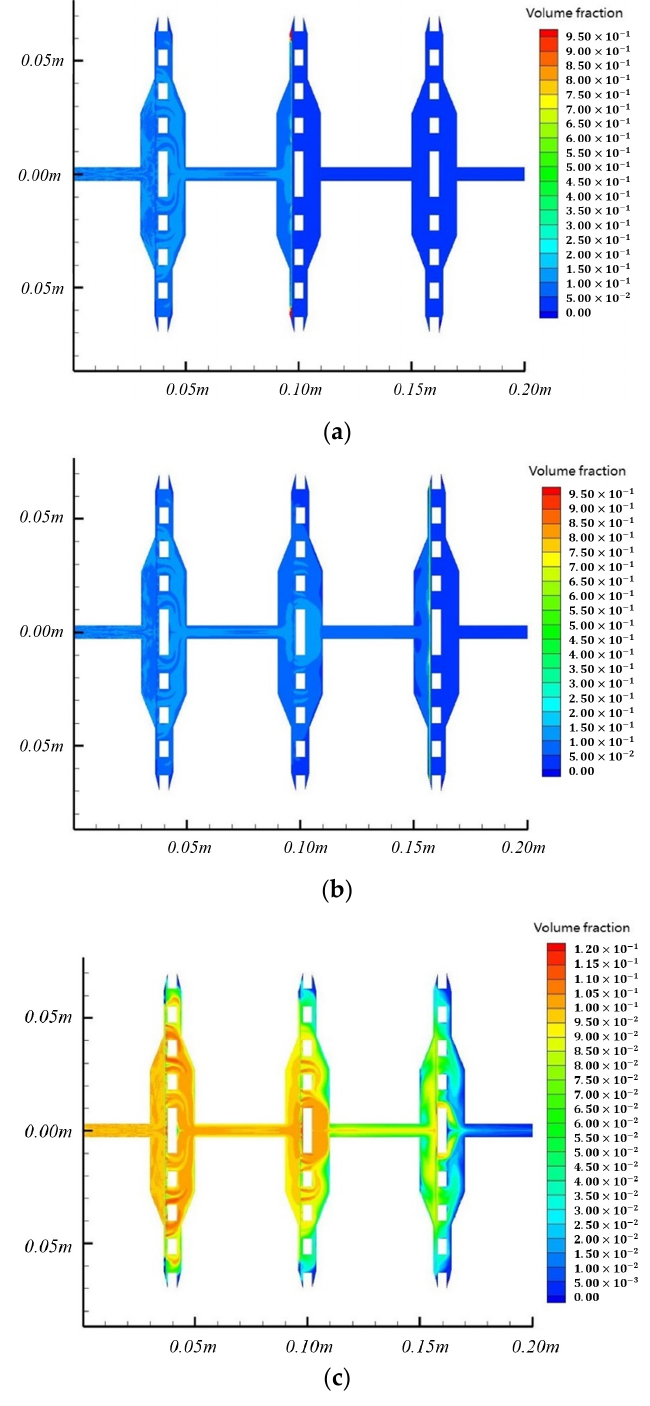
Figure 8. The final volume fraction cloud image of 0.5 µ m, 0.25 µ m, and 0.08 µ m particles. ( a ) The final volume fraction cloud image of 0.5 µ m particles; ( b ) The final volume fraction cloud image of 0.25 µ m particles; ( c ) The final volume fraction cloud image of 0.08 µ m